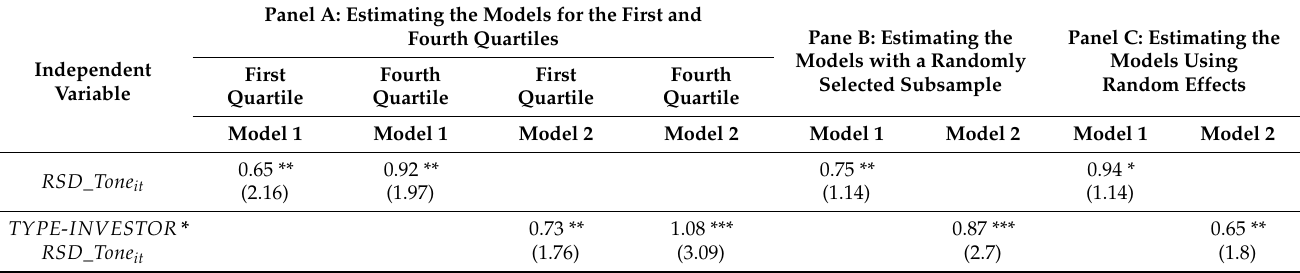
Table 5. Results of robustness